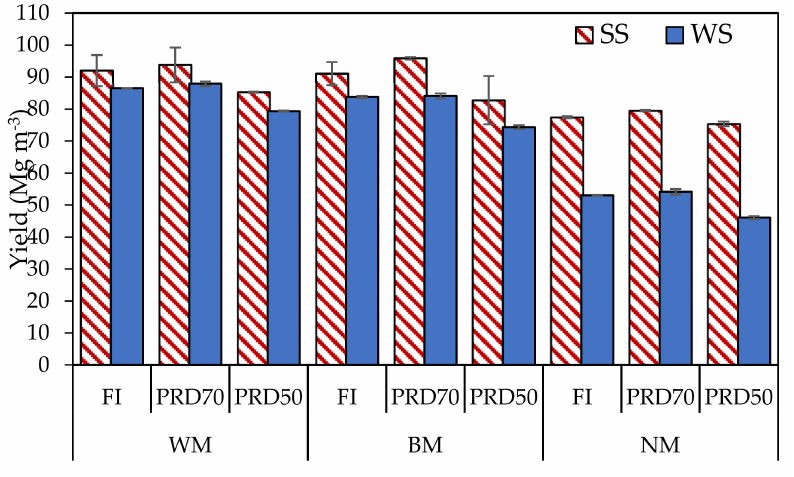
Figure 6. Squash yield under irrigation and mulch treatments during the winter and spring